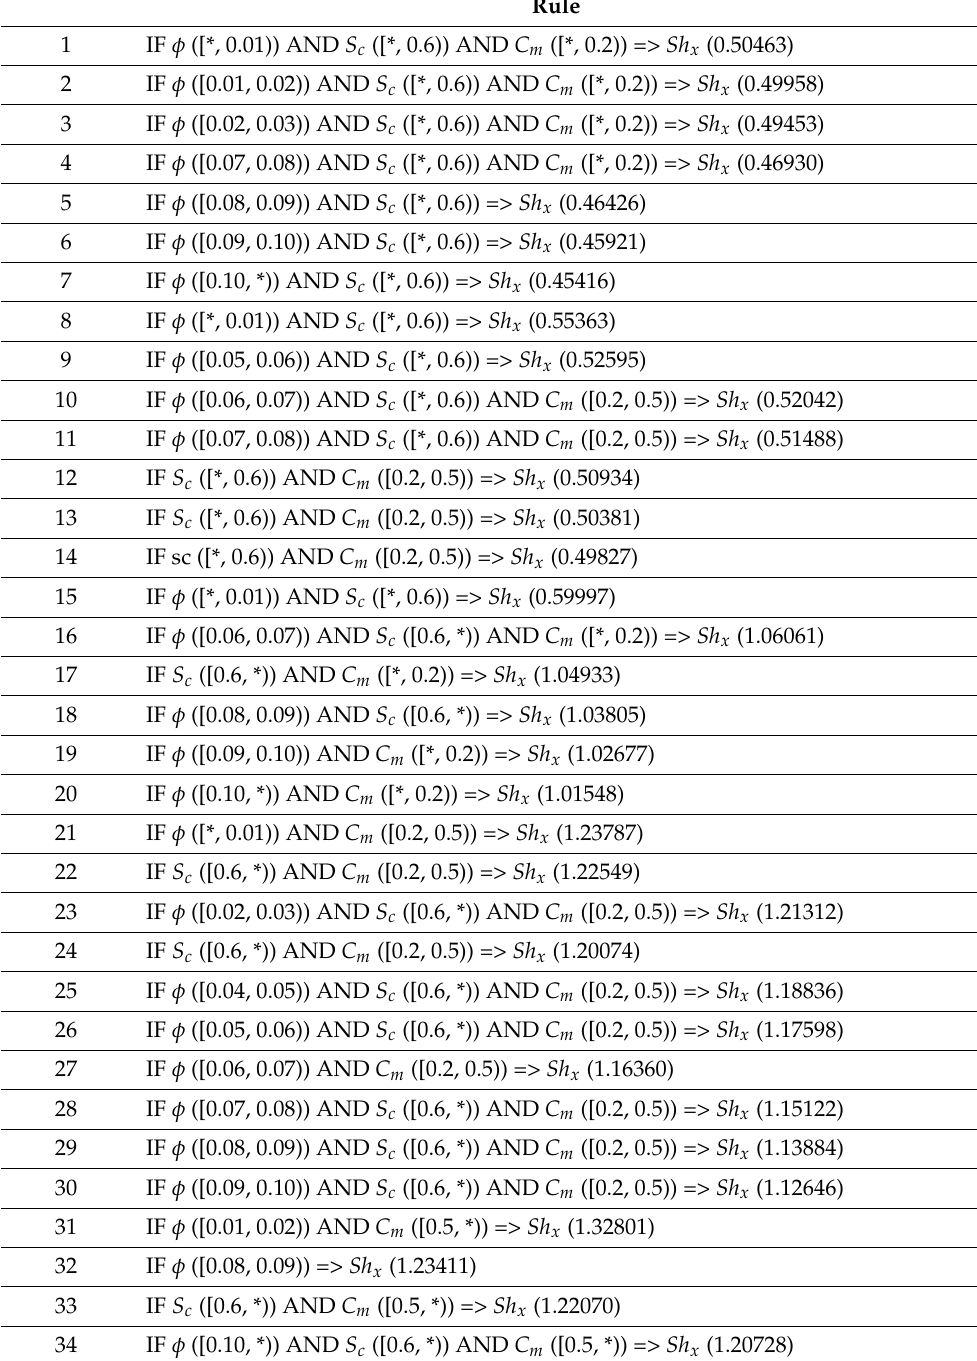
Table 6. The generated rules to predict the value of Sherwood number Sh x